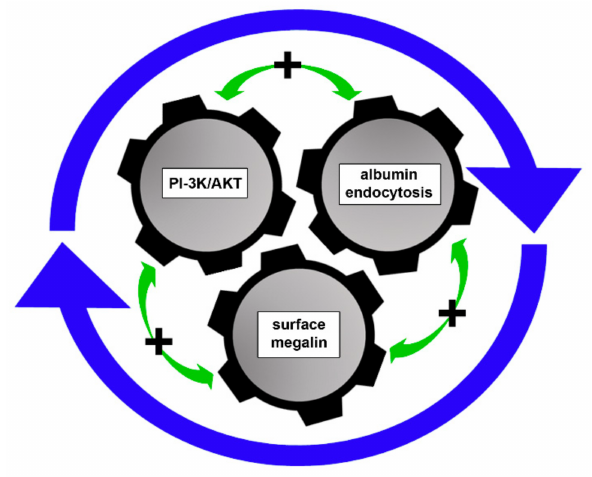
Figure 7. Proposed model. Our results suggest an intricate feedback loop between PI-3K/AKT pathway activation, albumin endocytosis, and surface megalin expression. These 3 components are intrinsically modulated, each being a modulator of the other. This overall process enhances albumin endocytic capacity in PT cells under physiologic